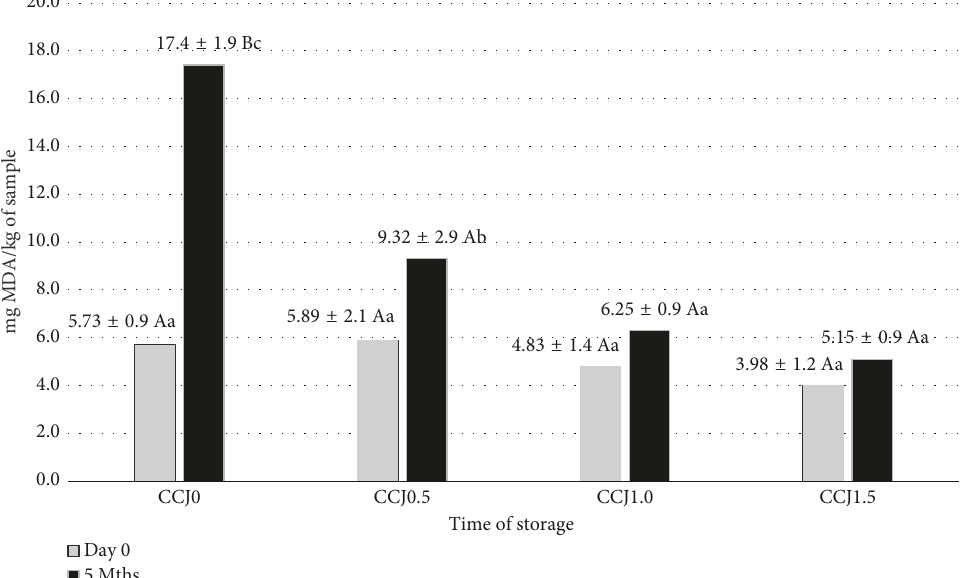
Figure 3: Thiobarbituric acid (TBA) values of beef burgers during storage, n � 3. Means followed by the different lowercase letters between the samples at the same storage time and capital letters between the same samples at different storage times indicate significant differences ( P ≤ 0 . 05) between